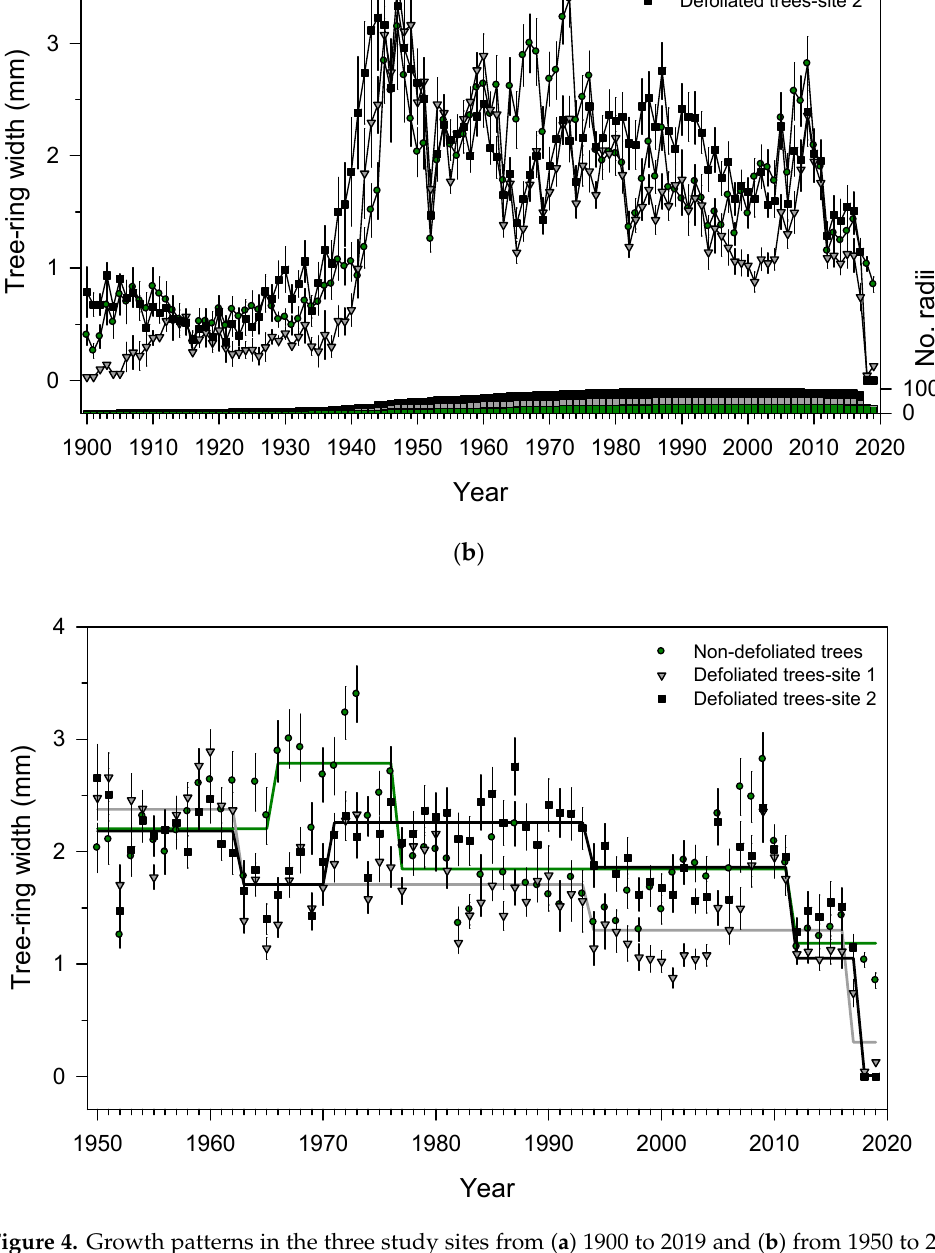
Figure 4. Growth patterns in the three study sites from ( a ) 1900 to 2019 and ( b ) from 1950 to 2019 with the results of regime shift analyses for the period 1950–2019. In both plots, mean annual values of ring width are presented with SEs. In the lower plot, the different levels of horizontal lines indicate significant ( p < 0.01) values of the regime shift index in the three stands (Non-defoliated trees, green symbols and lines; Defoliated tree site 1, grey symbols and lines; Defoliated tree site 2, black symbols and lines).